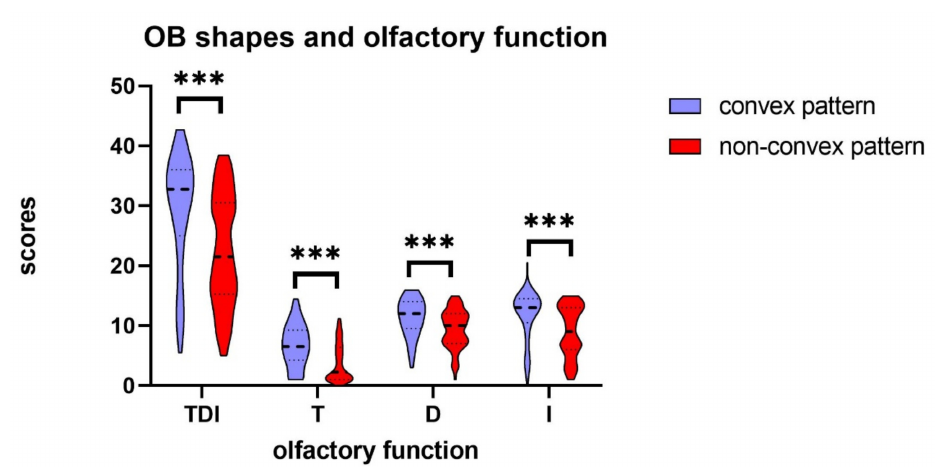
Figure 5. Violin plot comparisons of olfactory scores between subjects with convex pattern OB and subjects with non-convex pattern OB showing the median (a black dash line in the center of violin), and interquartile range (the black dot line on the violin plot). Subjects with non-convex pattern OB had significantly lower TDI total scores and T, D, and I component scores compared to subjects with convex pattern OB (all P ’s < 0.001), *** p < 0.001. TDI =